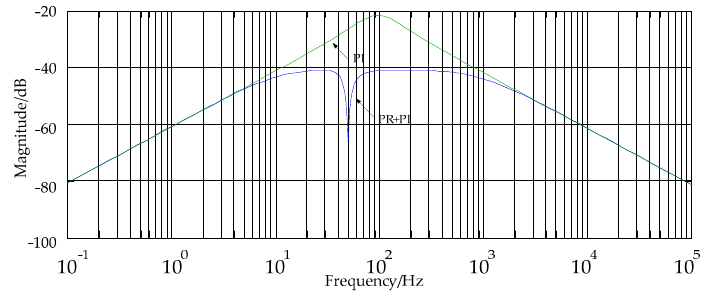
Figure 10. Amplitude-frequency curve from disturbance torque to speed.